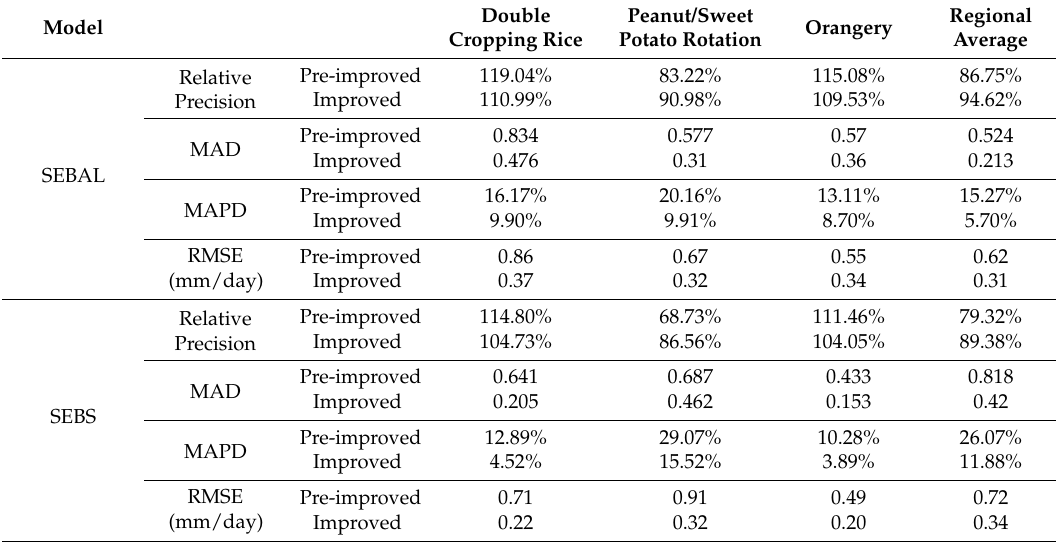
Table 2. Statistics of SEBAL and SEBS estimated versus observed ET at single point and ecosystem scales (MAD: mean absolute difference; MAPD: mean absolute percent difference; RMSE: root mean squared